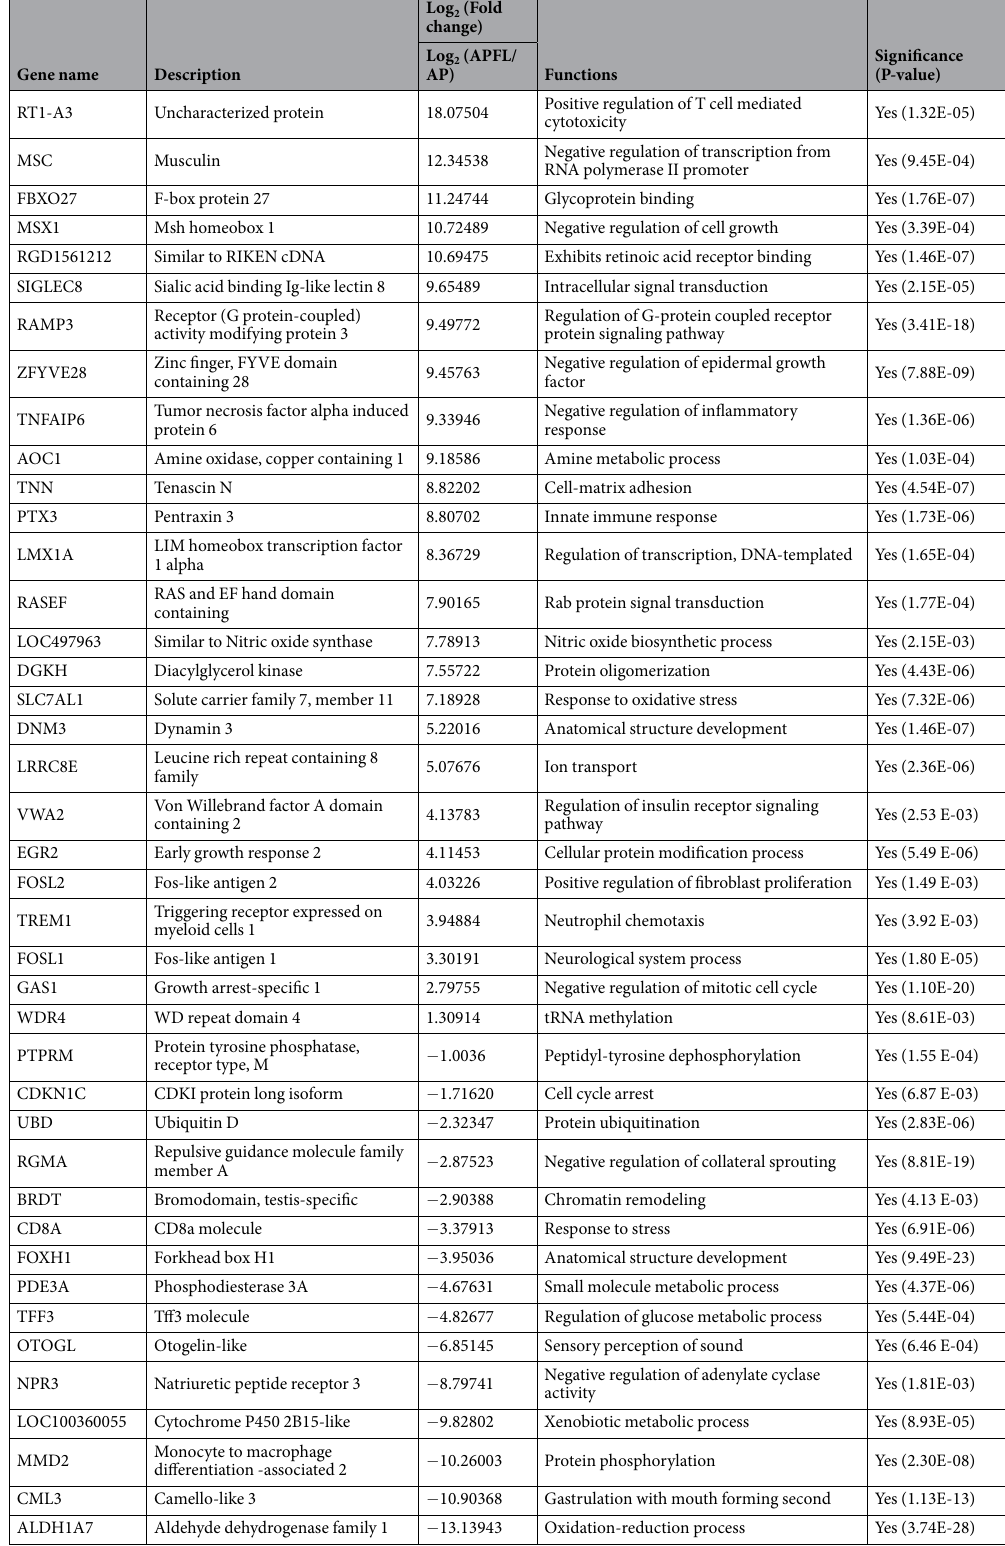
Table 1. List of representative dysregulated genes between APFL and